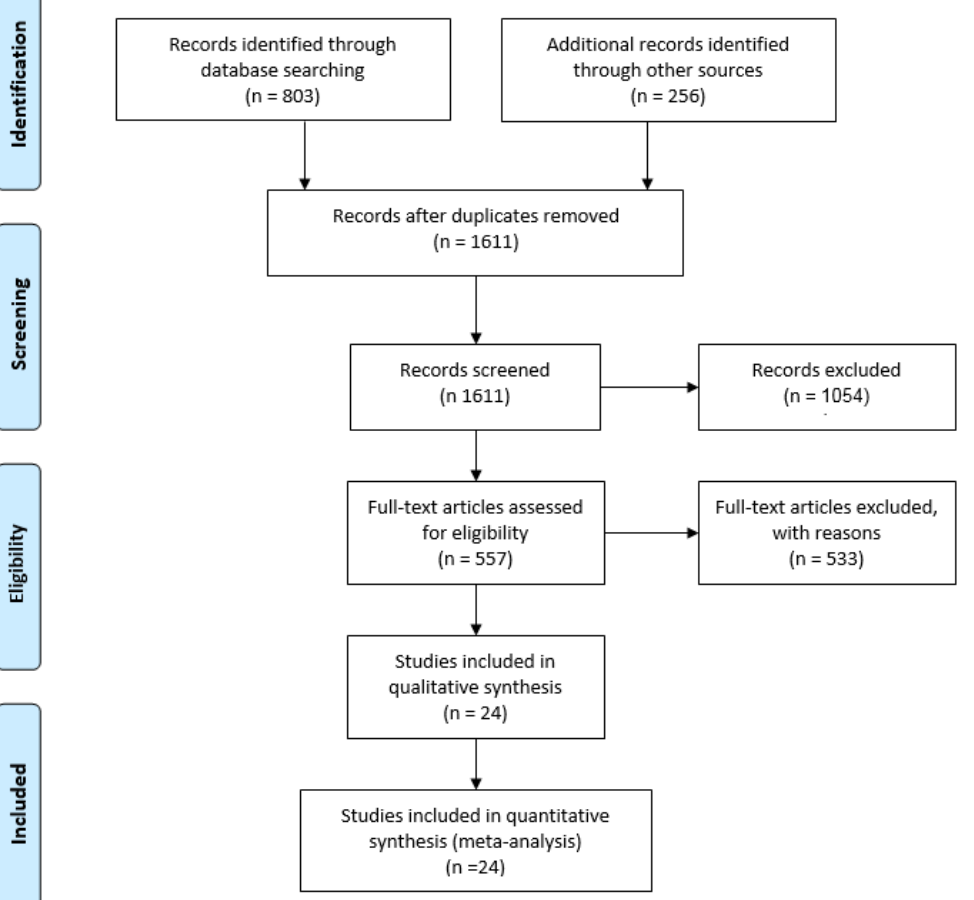
Figure 1. Study selection through the different phases using PRISMA framework [25].